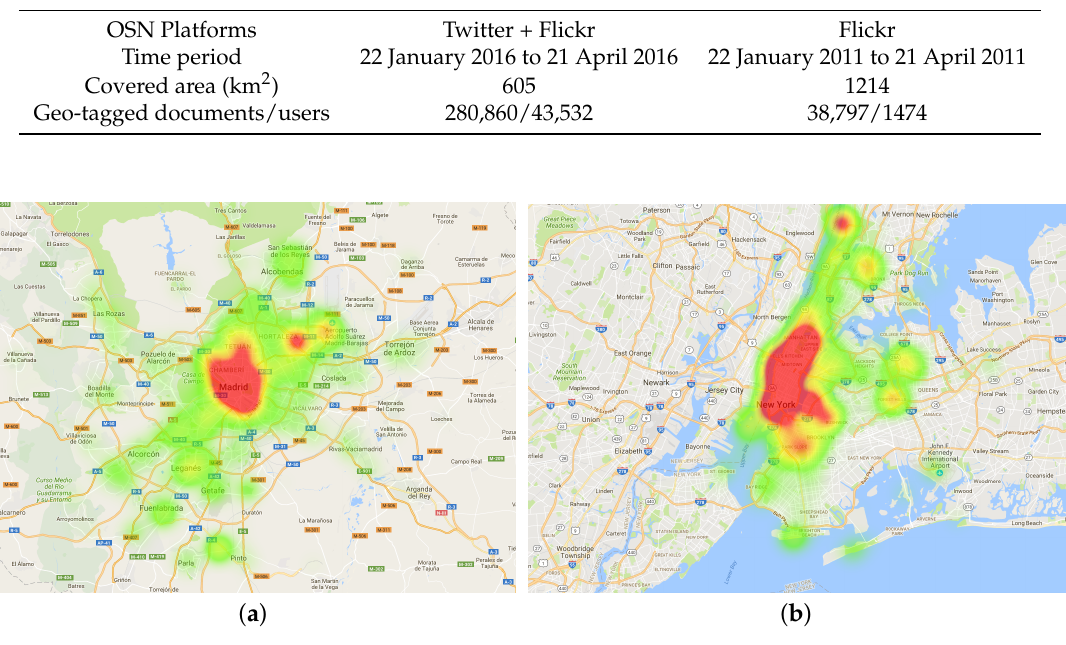
Figure 6. Heat map of documents density of the evaluated datasets. ( a ) Madrid (MD) Dataset (Twitter + Flickr); ( b ) New York (NY) dataset